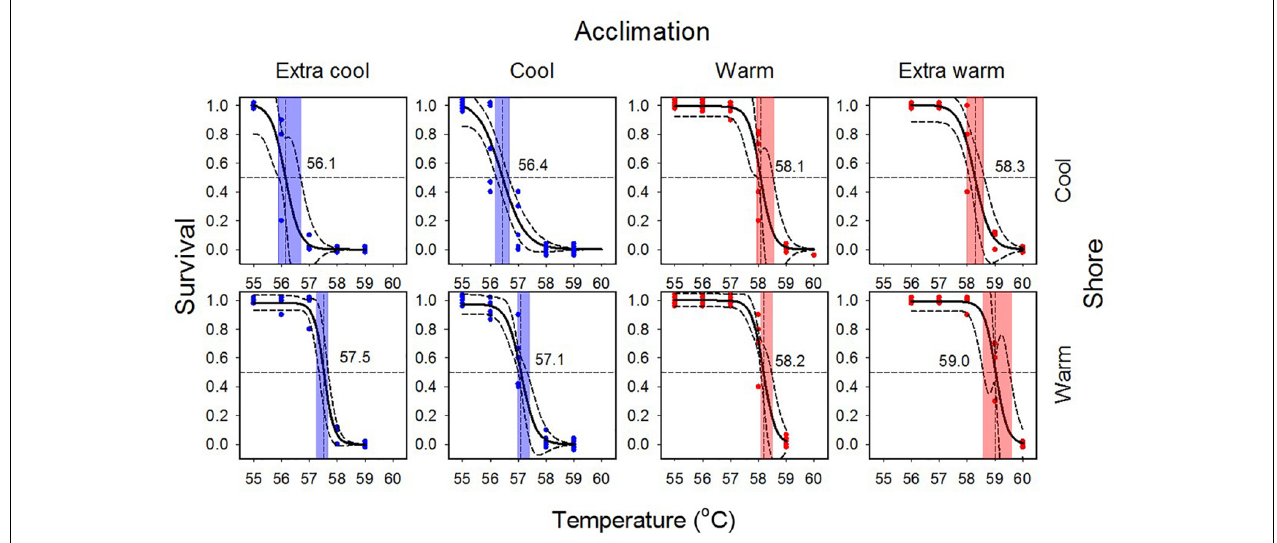
FIGURE 3 | Survival curves for laboratory-acclimated Echinolittorina malaccana snails from the cool (CS) and the warm shore (WS). Solid black logistic regressions are based on the combined data for each trial. Dashed lines associated with regressions represent 95% CIs. Colored symbols refer to individual trials for cool and warm acclimation (CA and WA, 5 trials) and extra cool and extra warm acclimation (ECA and EWA, 3 trials) using 50 snails per trial. Vertical lines indicate LT 50 values and their associated colored bands, their 95% CIs.